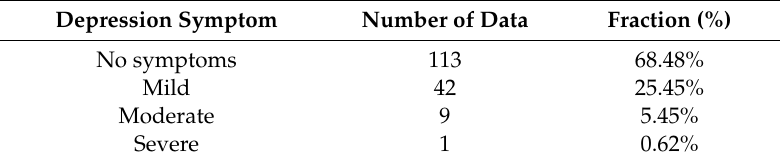
Table 11. Details of new unseen data for external validity.